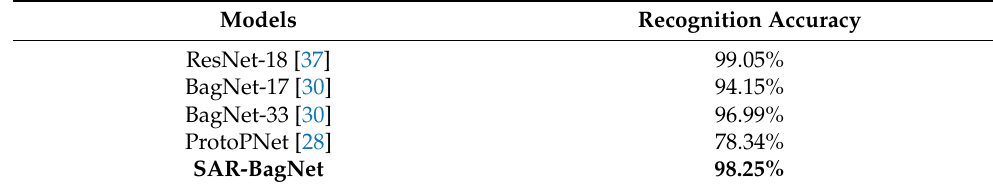
Table 1. The accuracy of the models on the validation set.